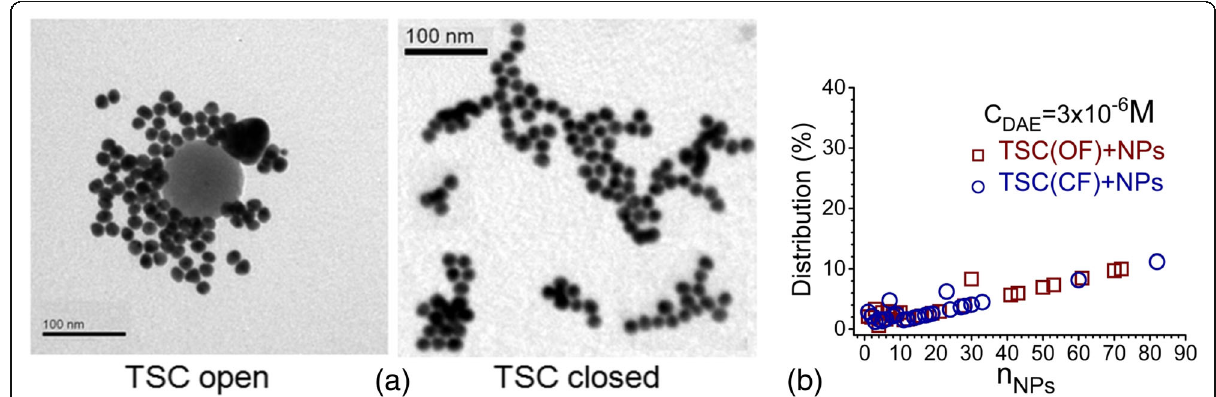
Fig. 8 a TEM images of obtained colloids, where C5F-TSC interacted with Au NPs in OF and CF at C DAE =3×10 -6 M. b The distribution of aggregates by quantity of NPs per